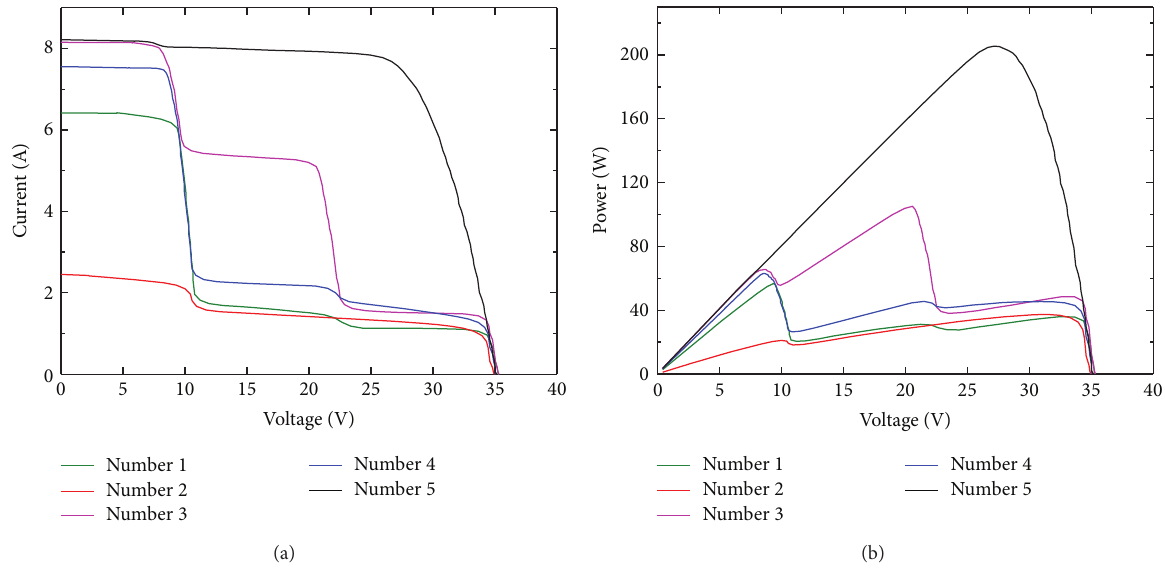
Figure 6: I-V curves and P-V curves of the five shaded PV modules. (a) I-V curves; (b) P-V curves.